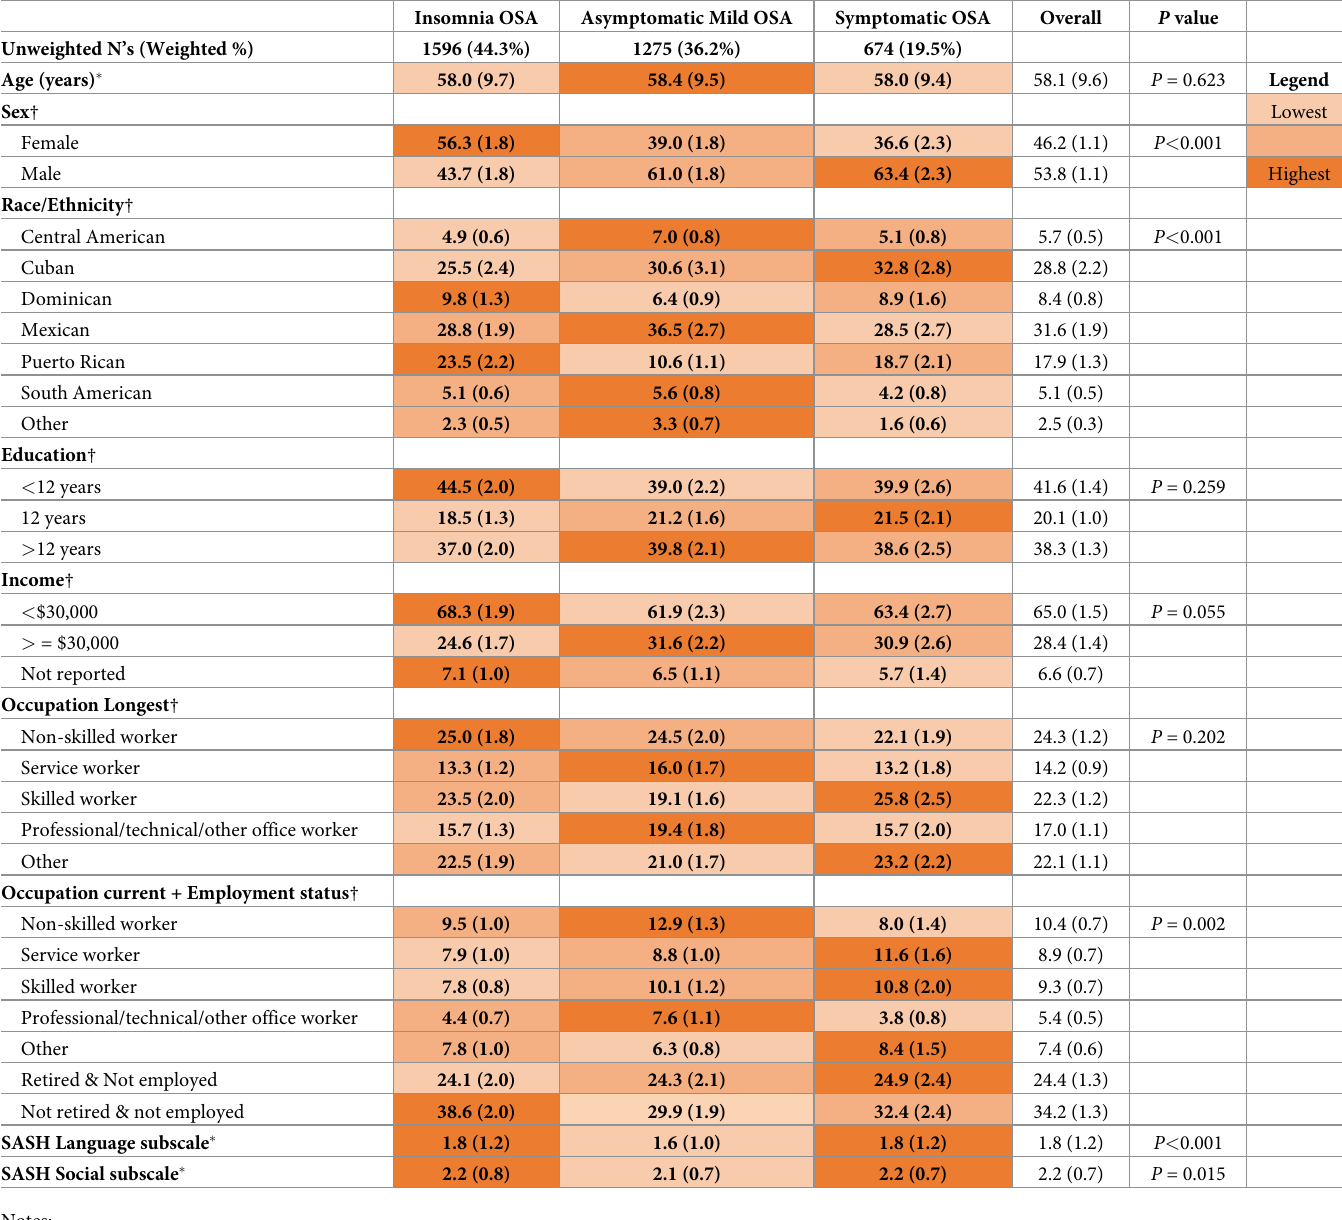
Table 2. Baseline sociodemographic and socioeconomic characteristics of HCHS/SOL individuals by primary solution of three derived sleep